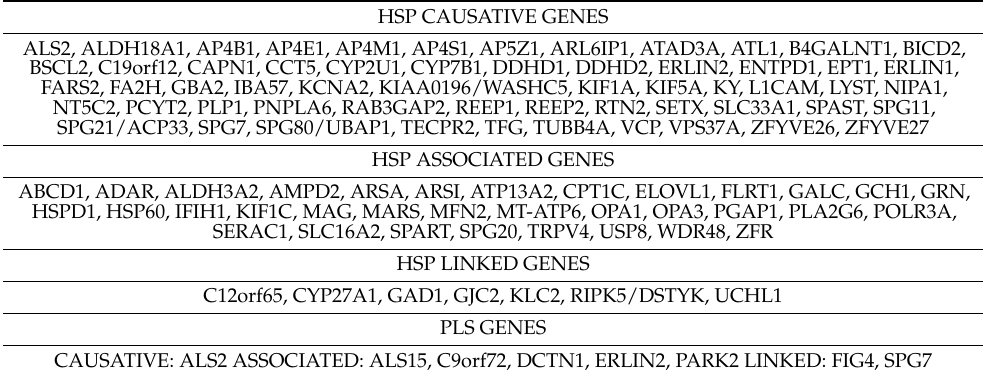
Table 1. List of genes that are either directly linked or associated with HSP and PLS.